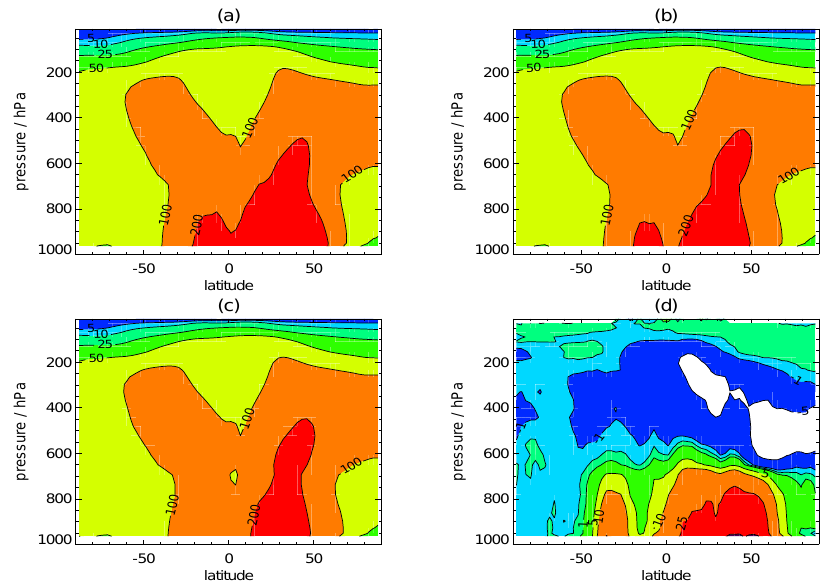
Fig. 5. Simulated zonal mean all-sky annual average cloud droplet number concentrations (CDNC) (in cm − 3 ) for a range of model simu- lations. (a) Including carbonaceous combustion aerosol emissions, (b) without pollution (fossil fuel and biofuel) carbonaceous combustion aerosol emissions, (c) without carbonaceous combustion aerosol emissions, (d) percentage change in zonal mean CDNC due to pollution carbonaceous combustion aerosol (contour intervals: − 5%, − 1%, 0%, 1%, 5%, 10%, 25%, 50%).